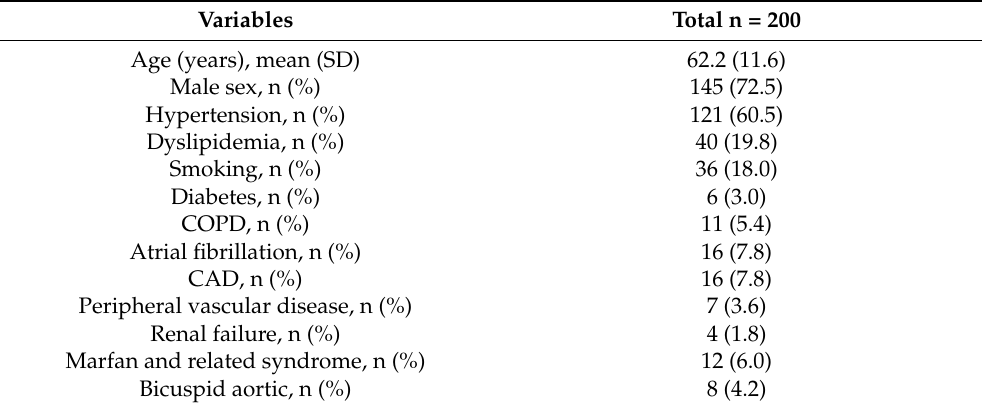
Table 1. Baseline characteristics.